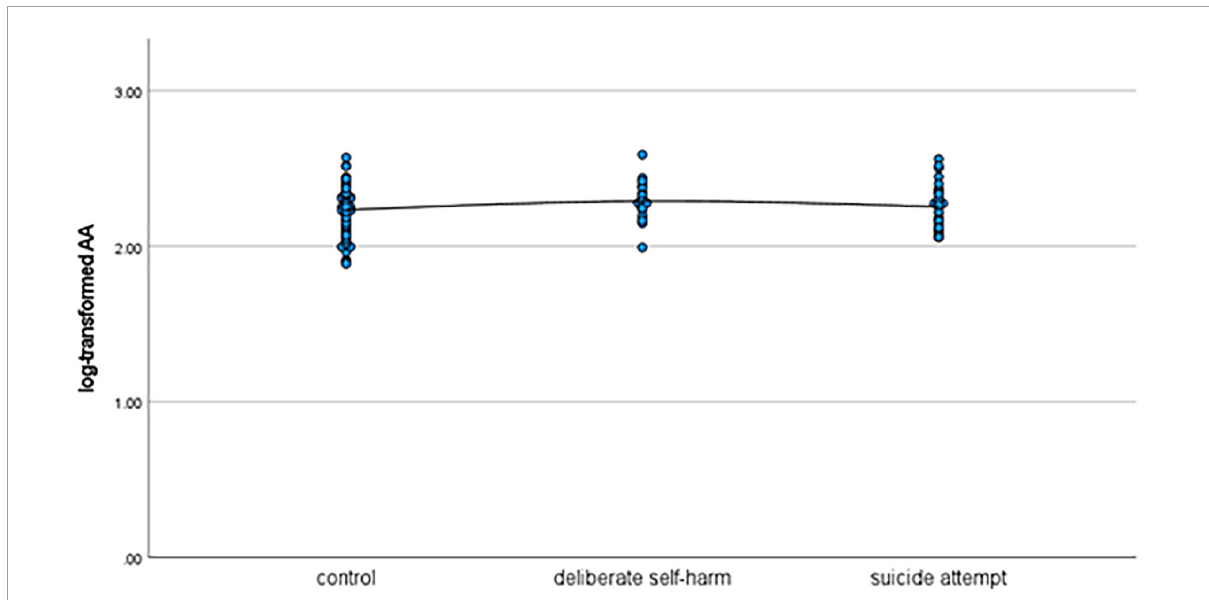
FIGURE4 Scattergram of log-transformed AA levels in the control, deliberate self-harm, and suicide-attempt